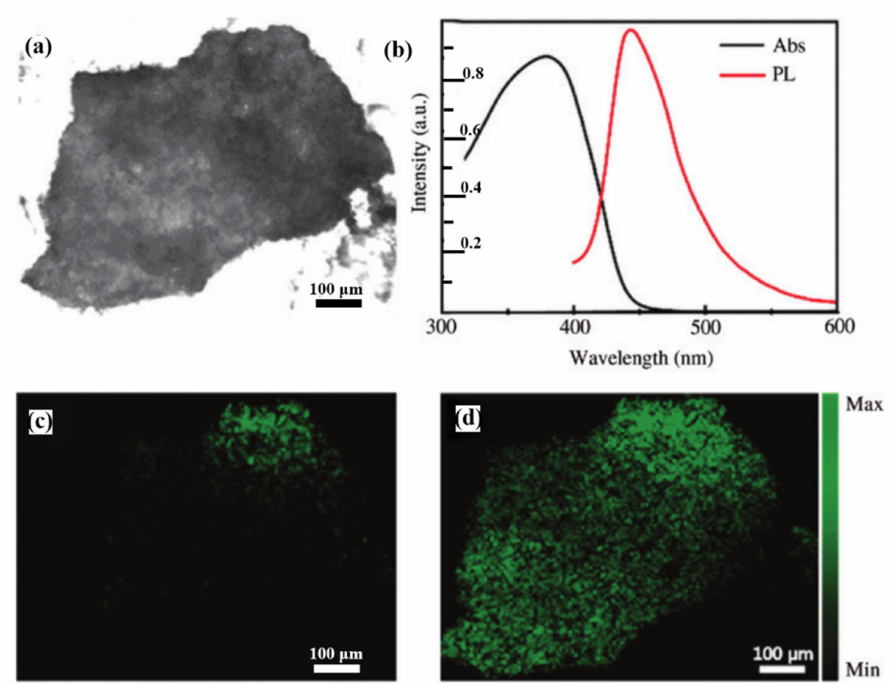
Figure 4. ( a ) Optical brightfield image of g-C 3 N 4 without Au@Ag NRs.( b ) Absorption and fluores- cence (PL) spectra of g-C 3 N 4 . ( c , d ) are the TPEF images of g-C 3 N 4 without and with Au@Ag NRs on the surface, respectively [42]. Republished with permission from Ref. [42]. Copyright 2022 Walter de